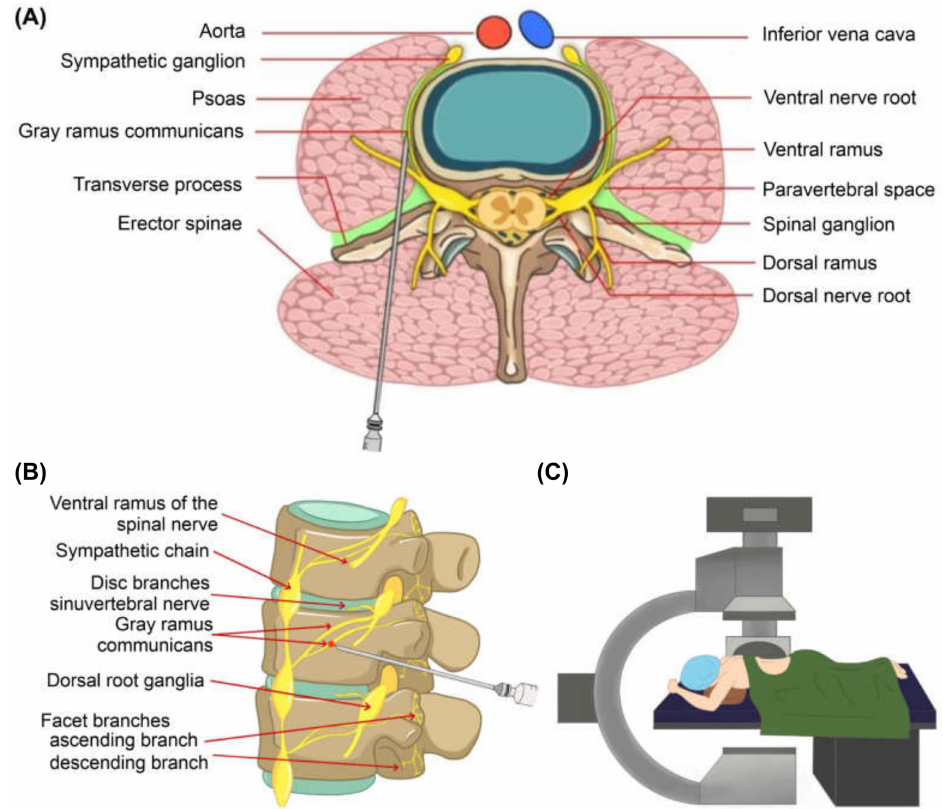
Figure 3. Illustration of gray ramus nerve block procedure: ( A ) axial view, ( B ) sagittal view, ( C ) the setting and position of patient and fluoroscopy for gray ramus communicans nerve